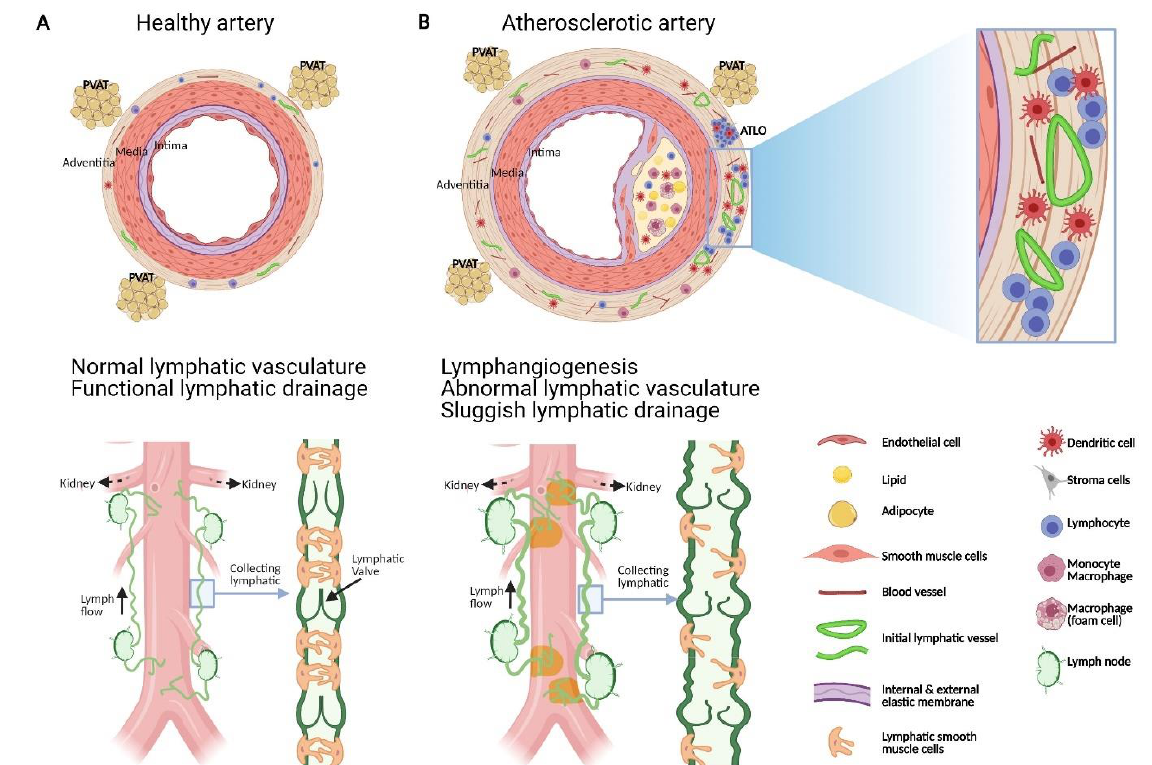
Figure 1. Schematic representation of the structural and functional changes affecting adventitial lymphatic vessels during atherosclerosis. ( A ) Artery is formed by three layers, namely: the tunica intima (inner layer) lined by a monolayer of endothelial cells, the tunica media composed of SMCs, elastin and collagen, and the adventitia, the outer layer formed of fibroblast, collagen, nerve endings, immune cells, blood and lymphatic vessels. Periadventitial adipose tissue (PVAT) is also distributed around arteries. ( B ) Atherosclerosis is characterized by the accumulation of plaques comprising cholesterol, inflammatory soluble factors, immune cells in the intima and inflammation in adventitia that can be associated with the formation of adventitia tertiary lymphoid organ (ATLOs) when the disease is more advanced. ( A ) Similar to lymphatic vessels in other tissues, initial lymphatic vessels in the adventitia converge into larger collecting vessels exhibiting SMC and valves which transport lymph into draining lymph nodes. ( B ) Studies have shown that atherosclerosis is associated with angiogenesis and lymphangiogenesis. Notably, in the abdominal aorta, initial lymphatic vessels appeared more dilated and lymphatic drainage of macromolecule from the adventitia into the draining lymph node is severely compromised during atherosclerosis. Alterations in collecting vessels such as poor SMC coverage, abnormal valve and accumulation of extracellular matrix such as collagen, may account for the impaired lymphatic drainage. These functional defects in adventitial lymphatic vessels may participate to the retention of immune cells, inflammatory cytokines, and lipids in the arterial wall which in turn favour the progression of atherosclerotic plaque, inflammation and ATLOs. Restoring lymphatic drainage in the arterial wall may thus be a promising strategy to treat